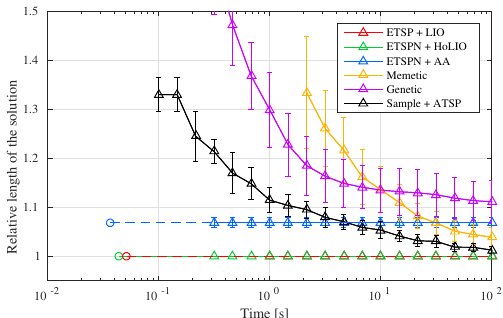
Figure 4. Average ratio of the tour length (from 50 trials) according to the ETSP+LIO solution for the DTSPN with n =40 convex regions. Plots start from the time when the first solution is